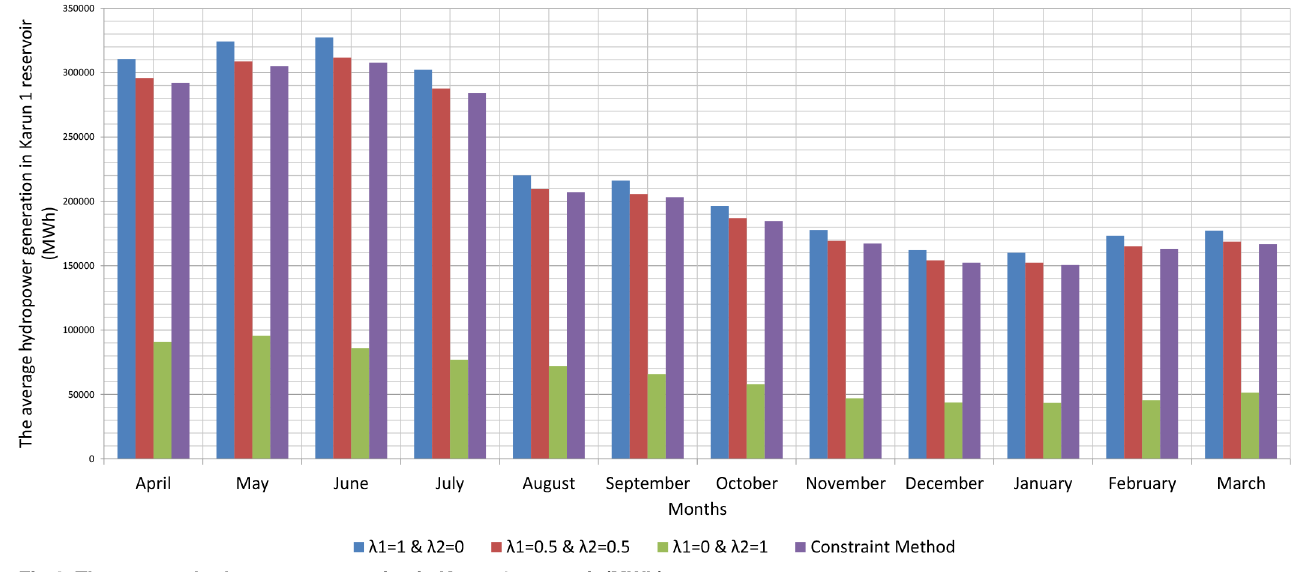
Fig 4. The average hydropower generation in Karun 1 reservoir (MWh).